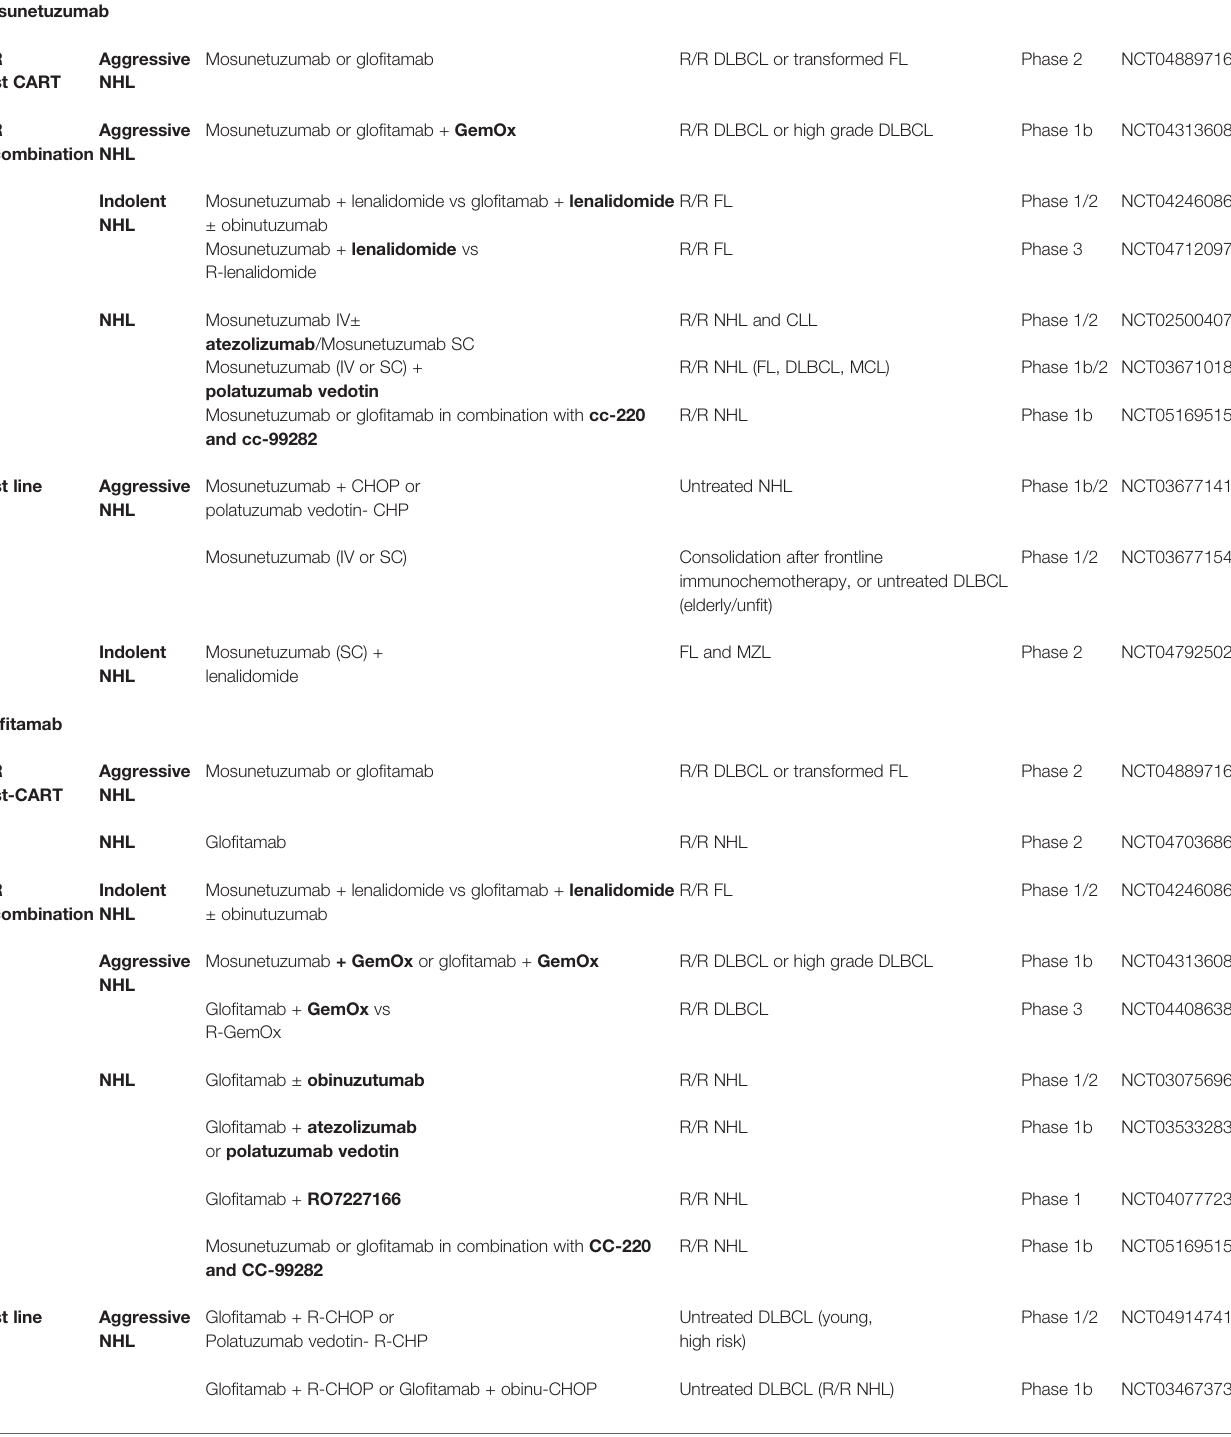
TABLE 2 | Ongoing trials with IgG-like bispeci fi c antibodies in lymphoma, with the clinical trial identi fi er.